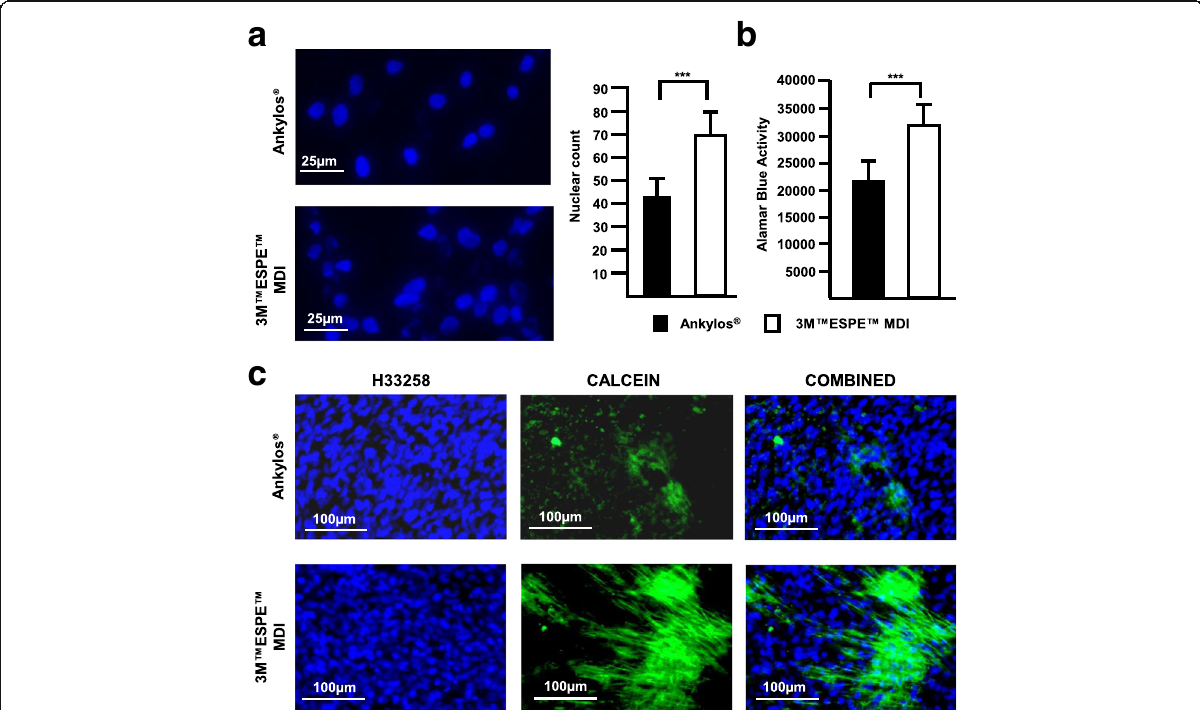
Fig. 5 a Florescence microscopy showing H33258-stained MC3T3-E1 cells on Ankylos® and 3M ™ ESPE ™ MDI disks. Although equal numbers of cells were plated, after 12 days of culture, more cells were detected on the 3M ™ ESPE ™ MDI disks. b Increased Alamar blue® reduction in MC3T3-E1 cells seeded on 3M ™ ESPE ™ MDI disks when compared to cells cultured on Ankylos®. c Increased mineral deposition in the MC3T3-E1 cultures on the 3M ™ ESPE ™ MDI disks in comparison to those on the Ankylos® disks as detected by calcein